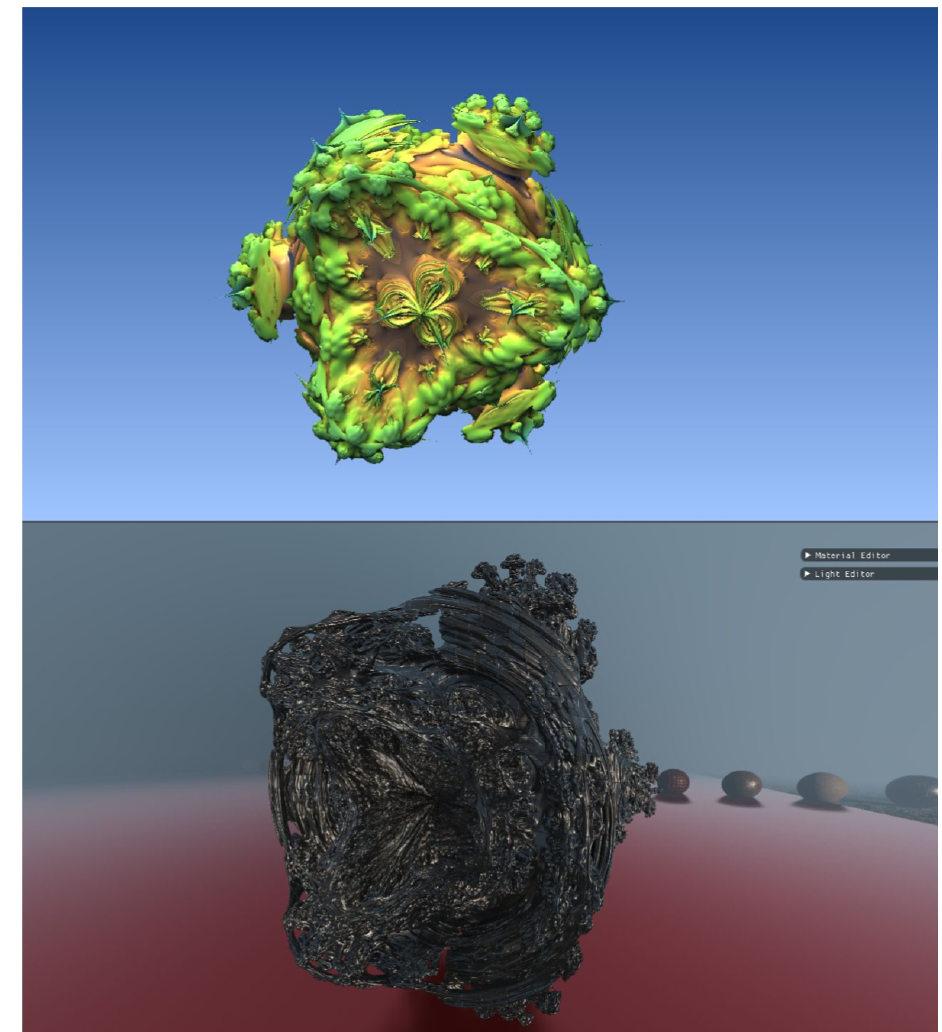
Figure 5. A power 4 Mandelbulb rendered in Mandelbulb3D ( top ) and our raymarcher ( bottom